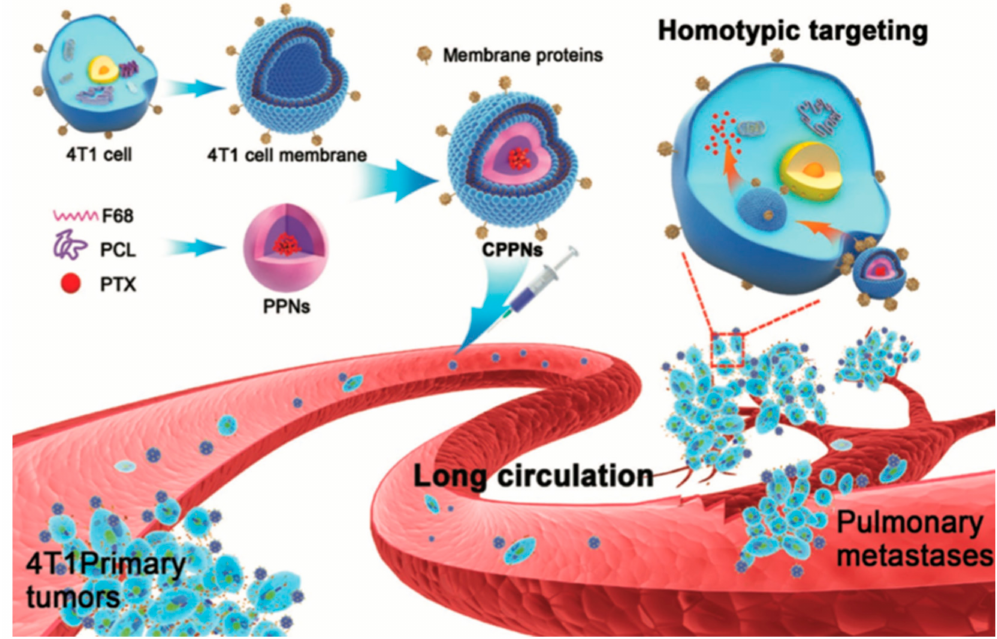
Figure 2. Schematization of homotypic cancer targeting using CMC-NPs. Reproduced, with permission, from Ref.